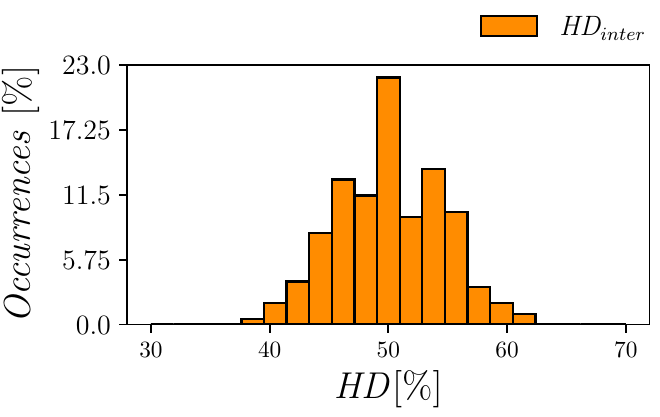
Figure 7. Histogram of the Uniqueness in terms of HD inter measured over 21 chip samples.